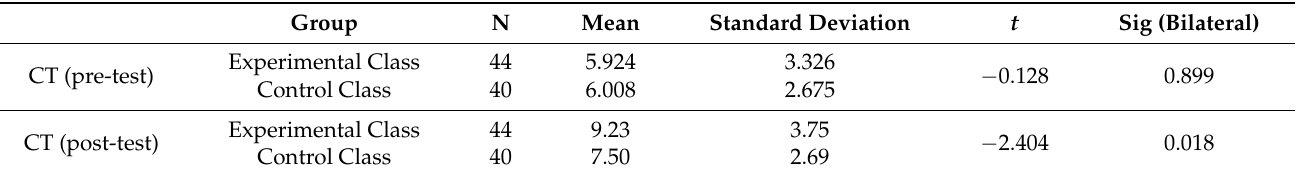
Table 2. Descriptive statistics and independent sample t -test of students’ CT performances in experimental class and control